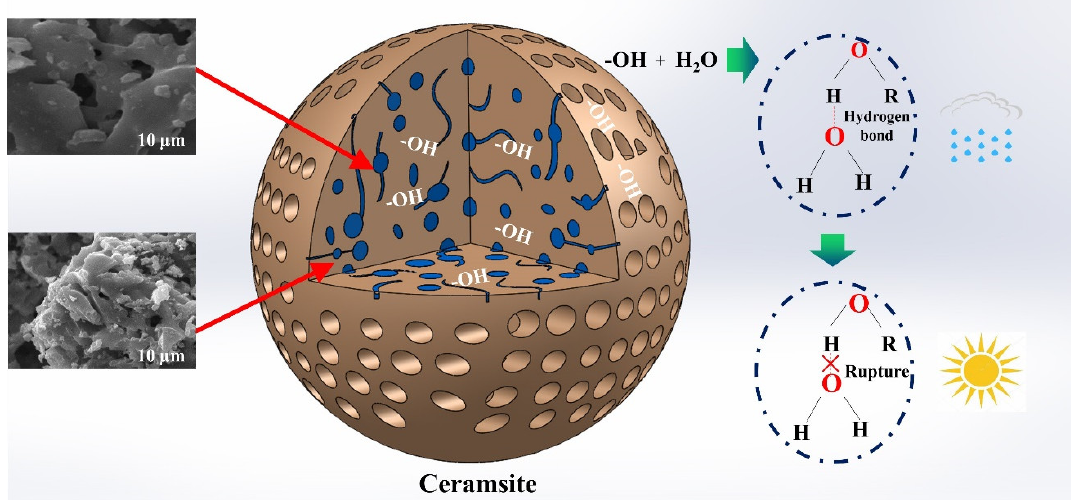
Figure 13. Diagram of water absorption and release mechanism of ceramsite .